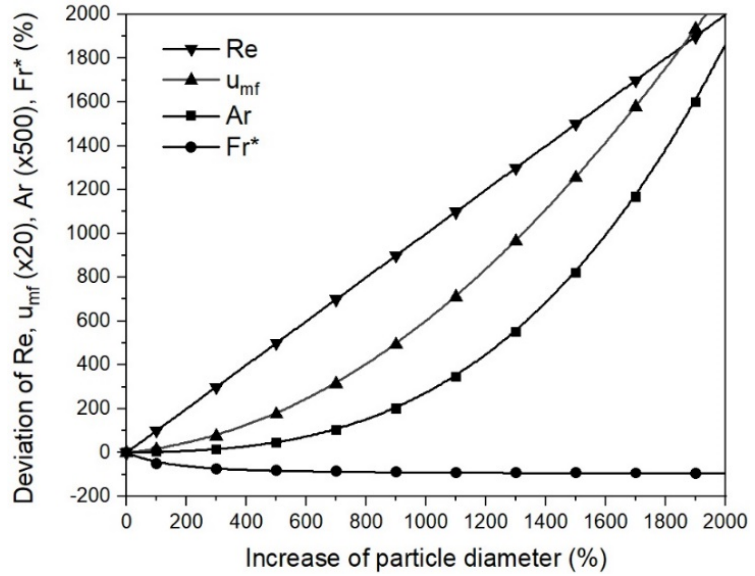
Figure 9. Sensitivity analysis for Re, Ar, Fr*, and u